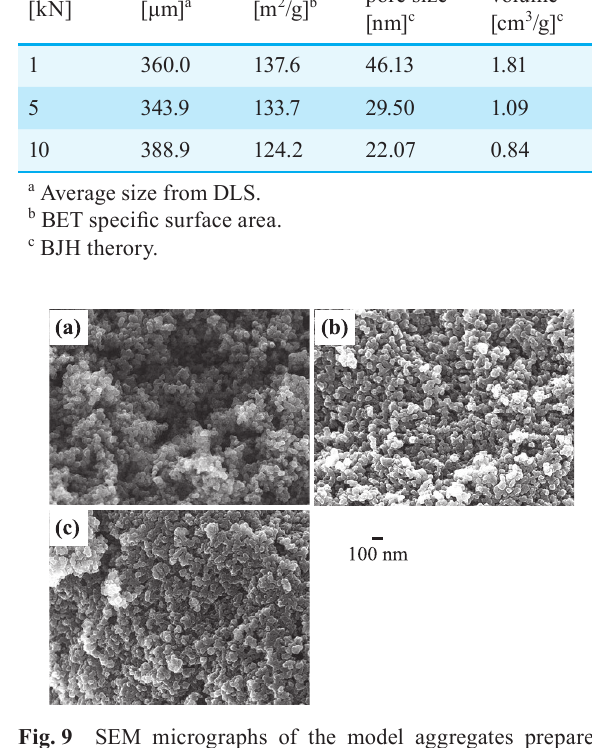
Fig. 9 SEM micrographs of the model aggregates prepared with (a) 1 kN, (b) 5 kN, and (c) 10 kN.